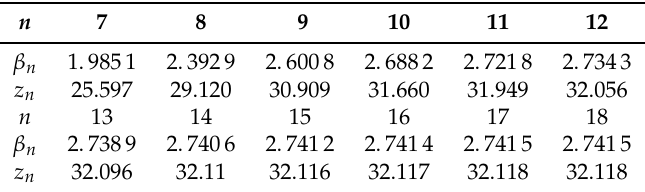
Table 1. Numerical data for β n and z n in Example